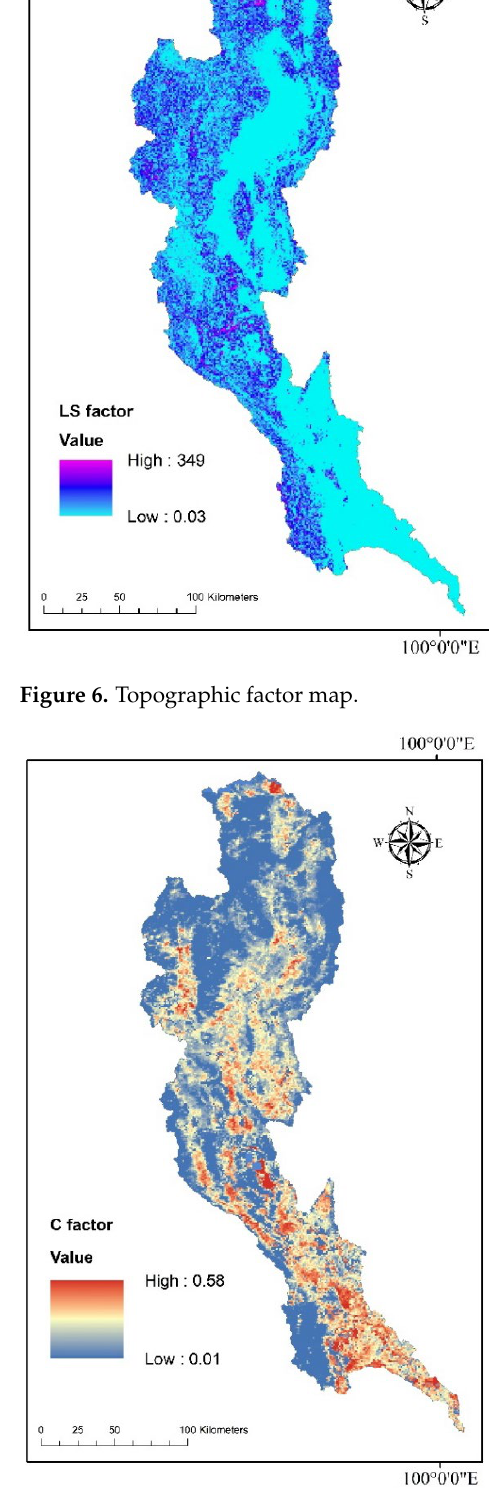
Figure 7. Cover-management factor map.